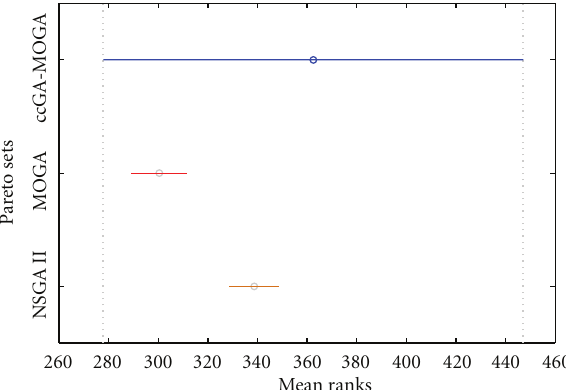
Figure 9: Wilcoxon rank sum test for the final crop numbers from the ccGA-MOGA, MOGA, and NSGA II Pareto sets.